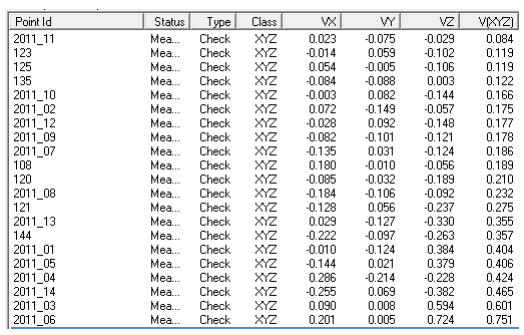
Table 5. Refine POSEO with Check Points